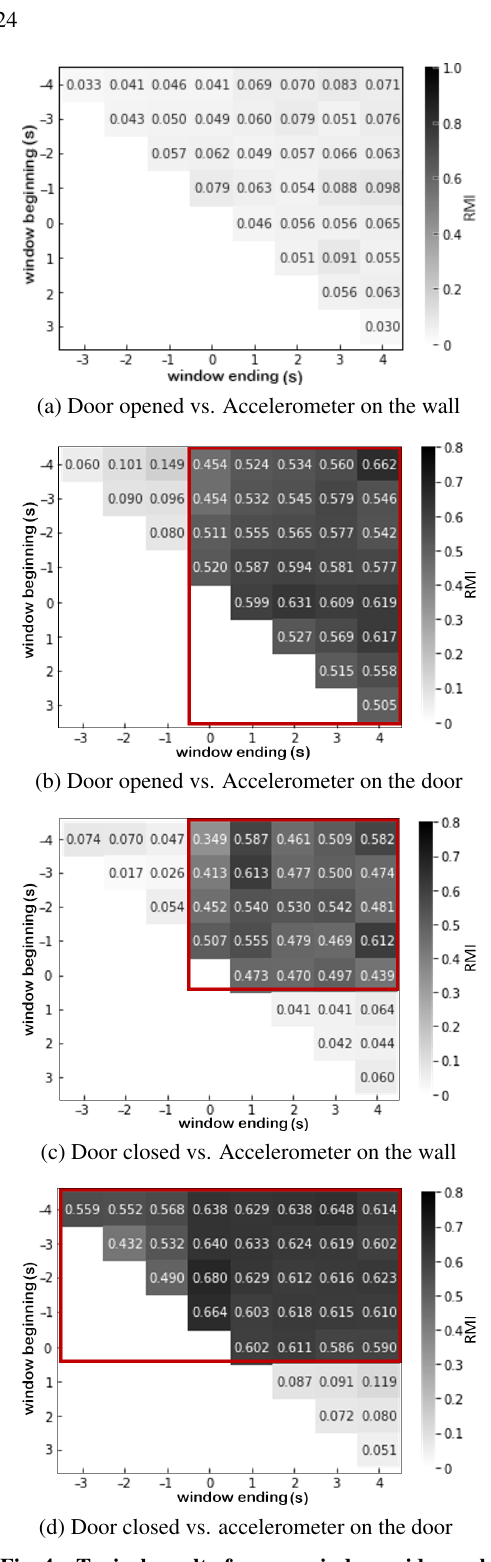
Fig. 4 Typical result of sensor window grid